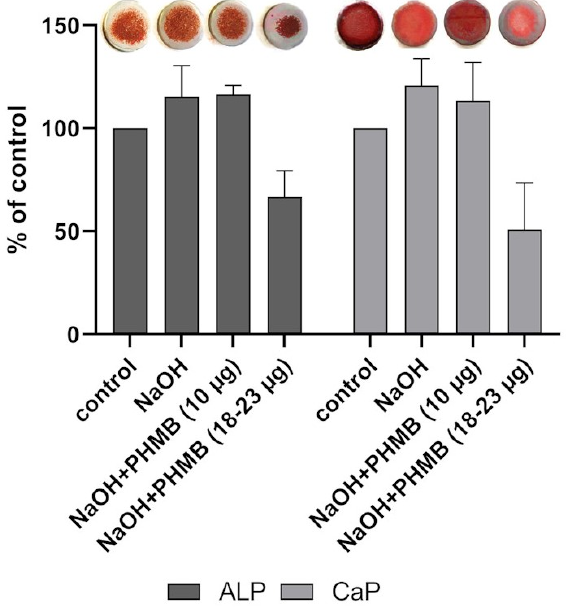
Figure 9. Staining of alkaline phosphatase and calcium apatite after 7 day culture of SaOs-2 os- teoblasts on Ti6Al4V specimens with different amounts of adsorbed PHMB. Higher amounts of PHMB led to a decreased formation of calcium apatite and a lower activity of alkaline phosphatase in comparison to untreated surfaces. Treatment with NaOH alone, and with low amounts of PHMB (10 µ g), had slightly increasing effects on ALP and CaP